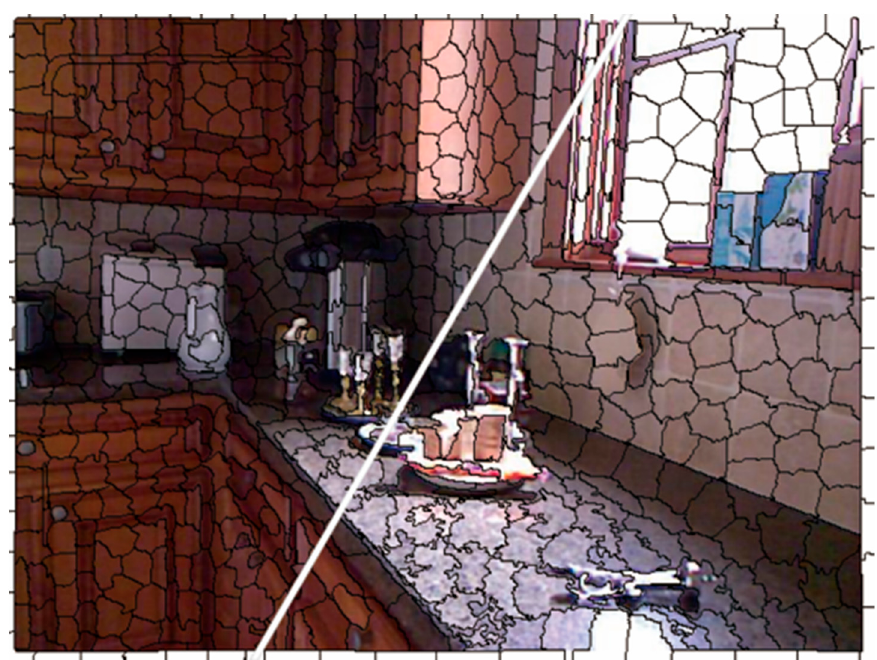
Figure 1. Superpixels generated by the weighted coplanar feature clustering (WCFC) algorithm on an RGB-depth (RGBD) image from the New York University (NYU ) Depth V2 dataset.